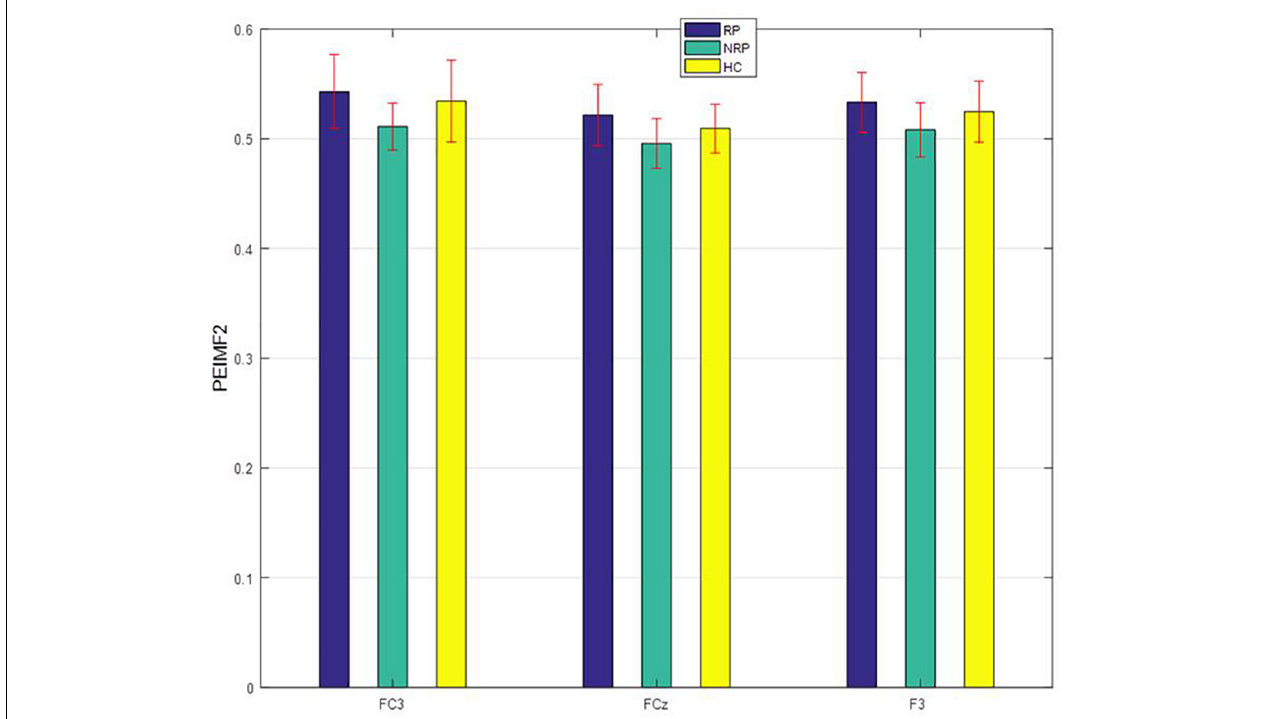
FIGURE 3 | PEIMF2 index as a function of electrode sites for RP and NR with comparison to HC participant groups. Error bars represent ± 1 standard error. RP differ than NR to rTMS treatment especially at